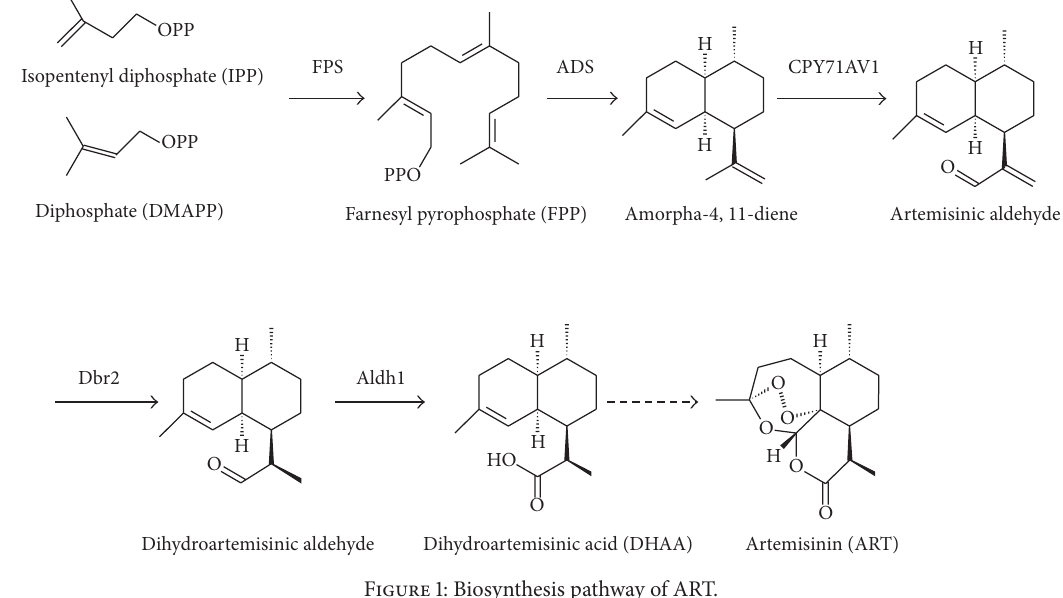
Figure 1: Biosynthesis pathway of